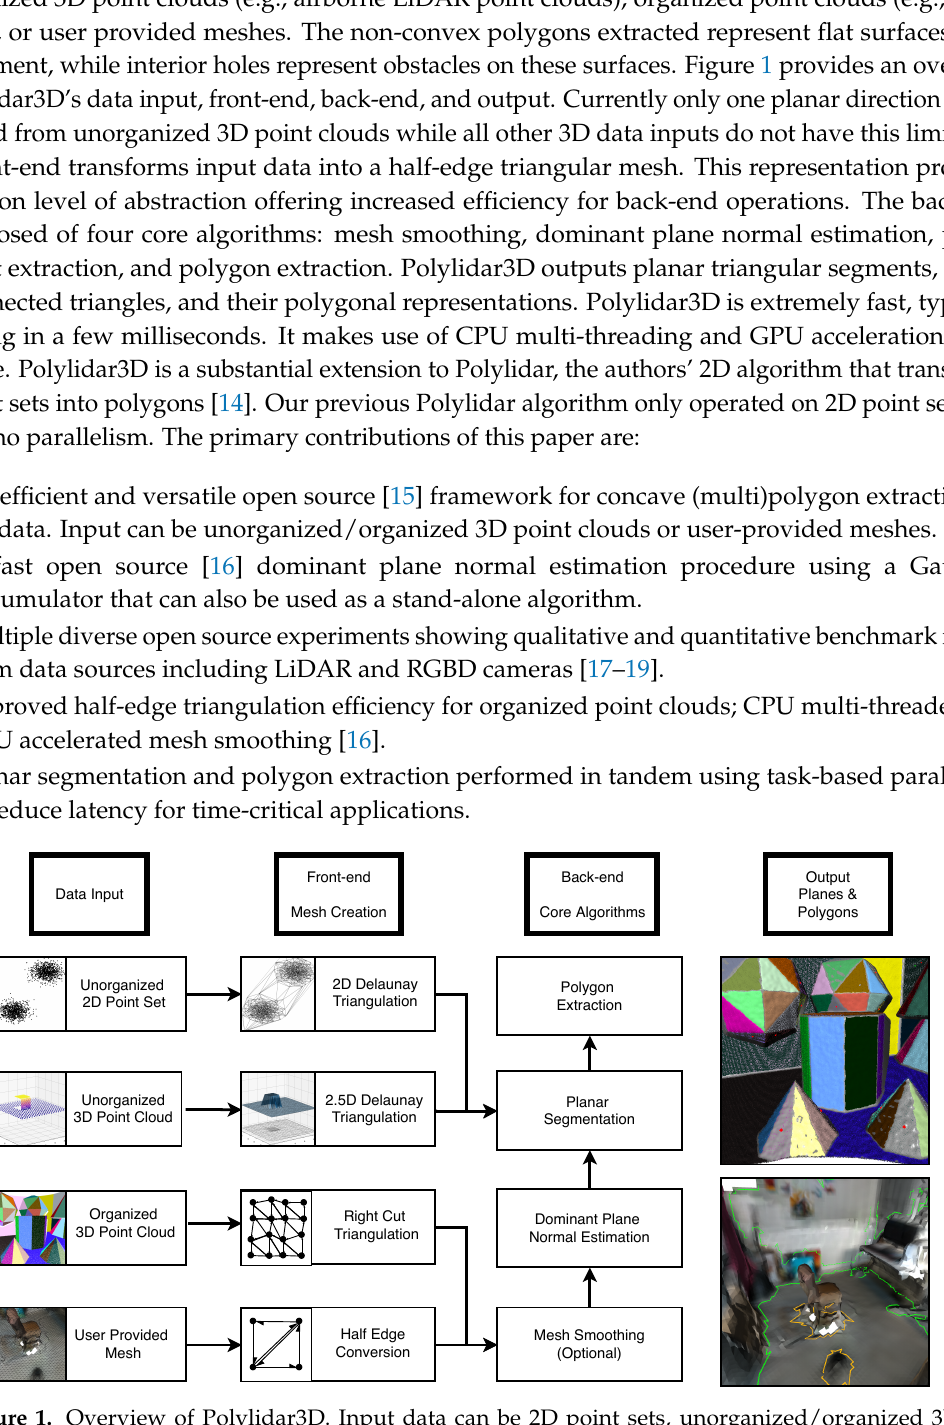
Figure 1. Overview of Polylidar3D. Input data can be 2D point sets, unorganized/organized 3D point clouds, or user-provided meshes. Polylidar3D’s front-end transforms input data to a half-edge triangulation structure. The back-end is responsible for mesh smoothing, dominant plane normal estimation, planar segmentation, and polygon extraction. Polylidar3D outputs both planes (sets of spatially connected triangles) and corresponding polygonal representations. An example output of color-coded extracted planes from organized point clouds is shown (top right). An example of extracted polygons from a user-provided mesh is shown (bottom right). The green line represents the concave hull; orange lines show interior holes representing